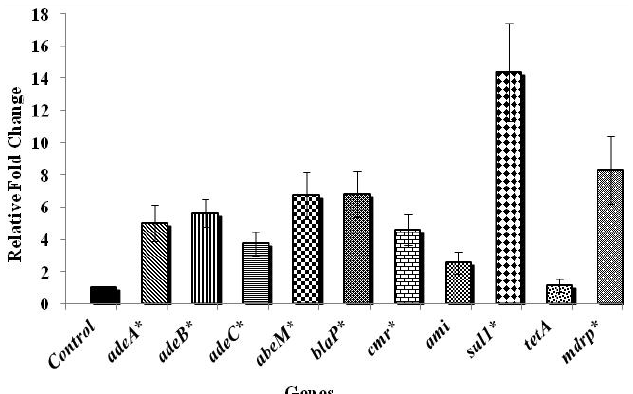
Figure 3. Effect of chlorine exposure on antibiotic resistance gene expression in A. baumannii